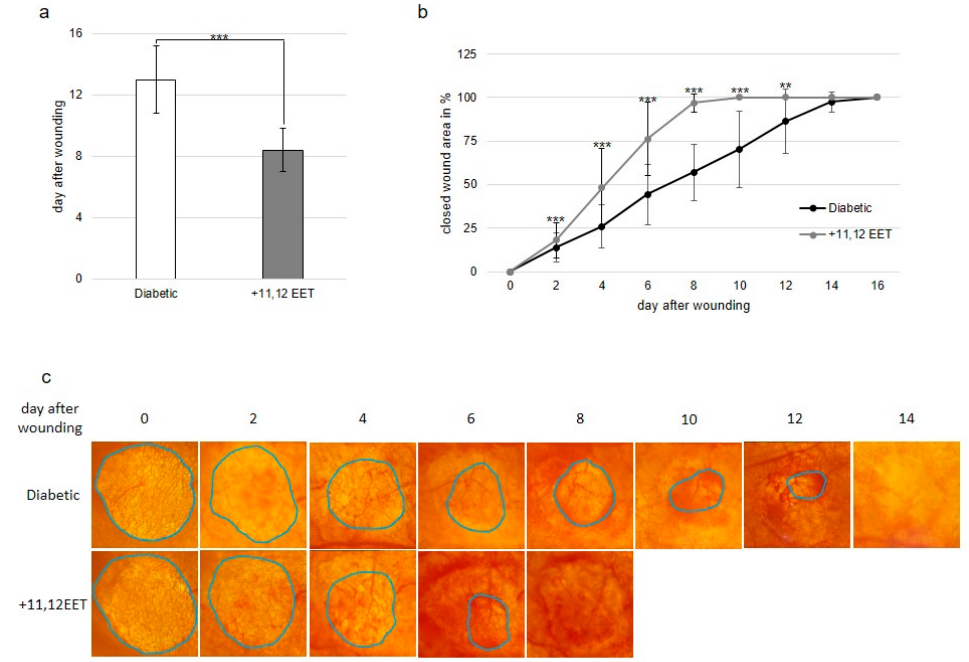
Figure 1. ( a ) Day of wound closure. Comparison between non-treated and 11,12 EET-treated wounds in diabetic mice. ( b ) Percentage of closed wound area from days 0–16. Comparison between wounds of diabetic animals and after treatment with 11,12 EET. ( c ) Representative pictures of wounds throughout the wound healing process in diabetic mice and after treatment with 11,12 EET. (Data are shown as mean ± SD; n = 20) ** p ≤ 0.01, *** p ≤ 0.001 .